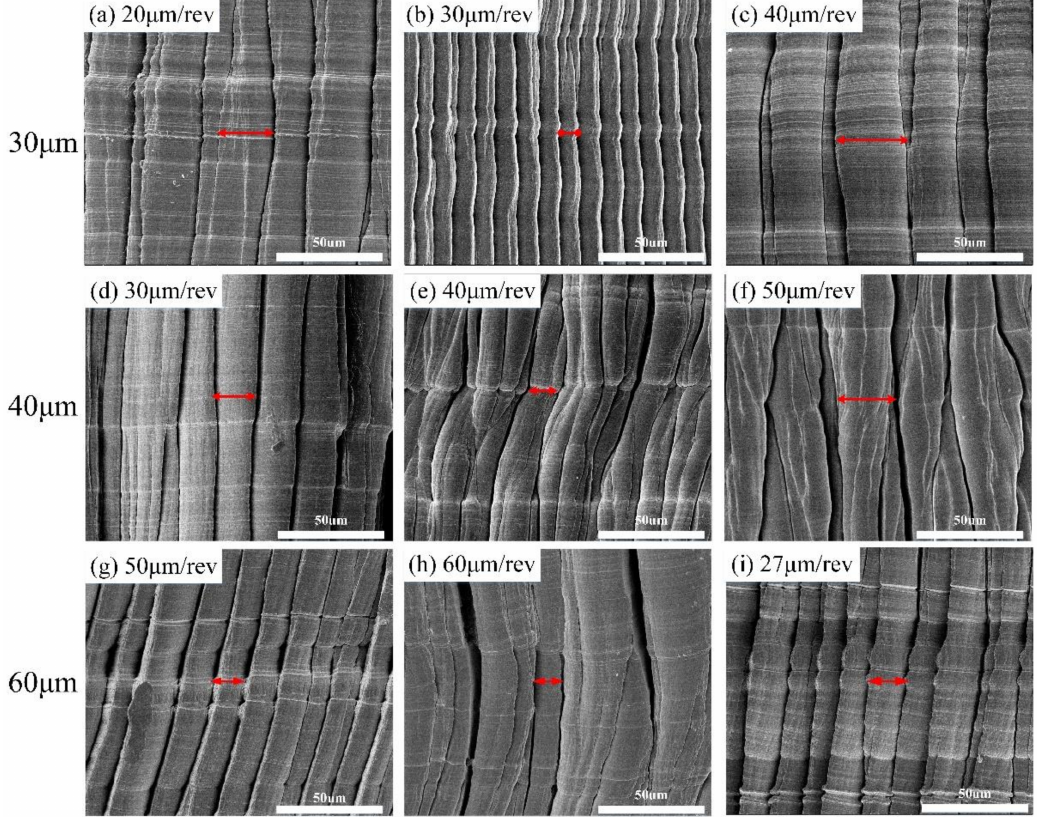
Figure 7. Micromorphology of free surface of workpiece chips at different feed rates. ( a – c ) Grain